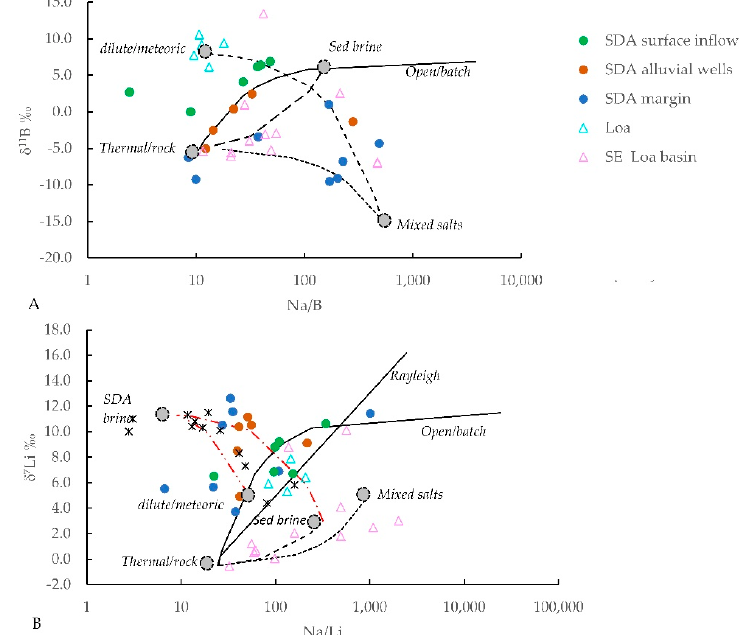
Figure 5. Diagrams showing the relationship between δ 11 B and Na/B ( A ), and δ 7 Li and Na/Li ( B ). Solid lines represent isotope fractionation following Rayleigh or batch (open) models for partitioning between solution and secondary minerals. Dashed lines represent mixing between different end-member reservoirs (filled gray circles ).